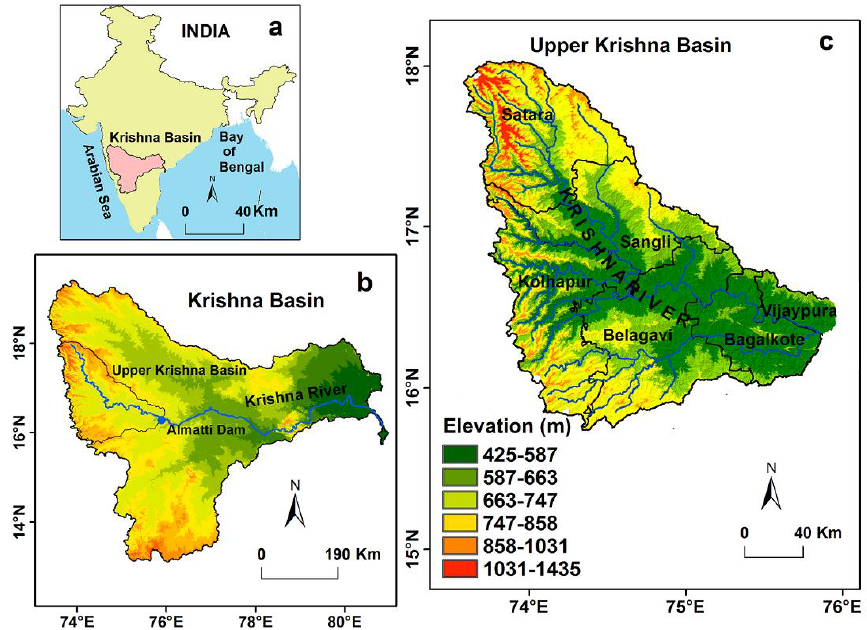
Figure 1. Study area: ( a ) India; ( b ) Krishna Basin; ( c ) Upper Krishna Basin.